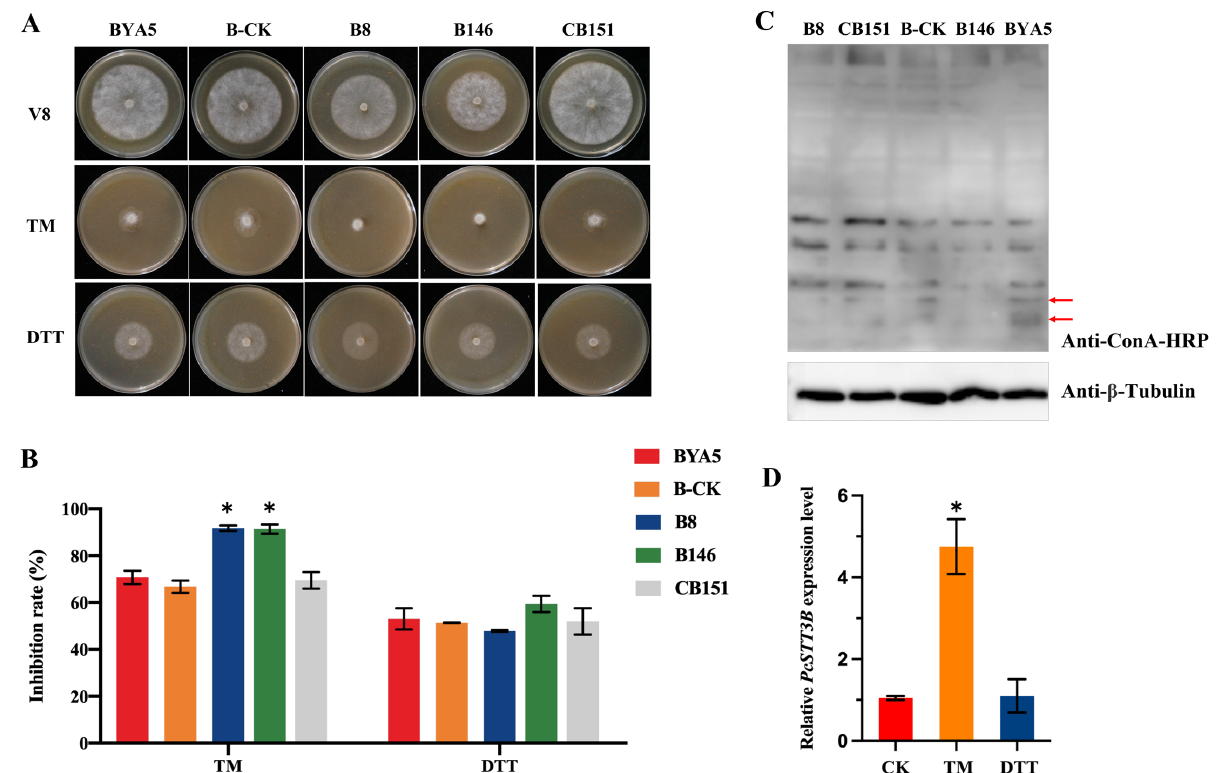
Figure 7. Roles of PcSTT3B in ER stress and N-glycosylation in P. capsici . ( A ) Mycelial growth assays of all strains on the V8 agar supplemented with 0.5 µg/mL TM or 6 mM DTT. TM, tunicamycin. DTT, dithiothreitol. ( B ) Mycelial inhibition rates under ER stress inducers. Colony diameters were measured 3 days after treatment. ( C ) Western blotting analysis for identifying glycoproteins. The total proteins of mycelia were extracted and analyzed by western blotting using an anti - ConA - HRP antibody. Red arrows represent certain mannosylated protein bands that slightly reduced in the PcSTT3B - deleted transformants compared to that of the BYA5 strain. β - tubulin was used as a load- ing control. ( D ) Relative PcSTT3B gene expression levels under ER stress inducers. The value of the un - treated control (CK) was set to 1 as a reference. Asterisks indicate significant differences from CK (*, p < 0.05). Data represent the mean ± standard deviations from three biological repeats.